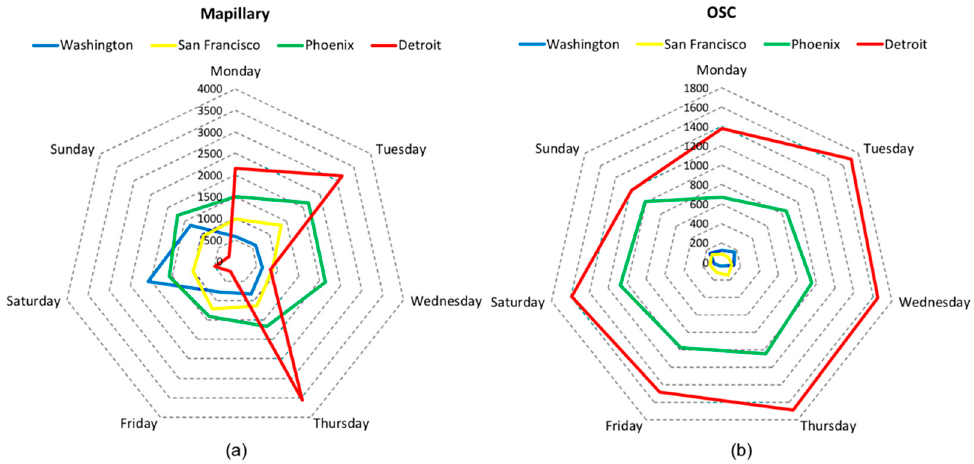
Figure 10. Number of images contributed during the days of the week in local time in ( a ) Mapillary and ( b ) OSC.